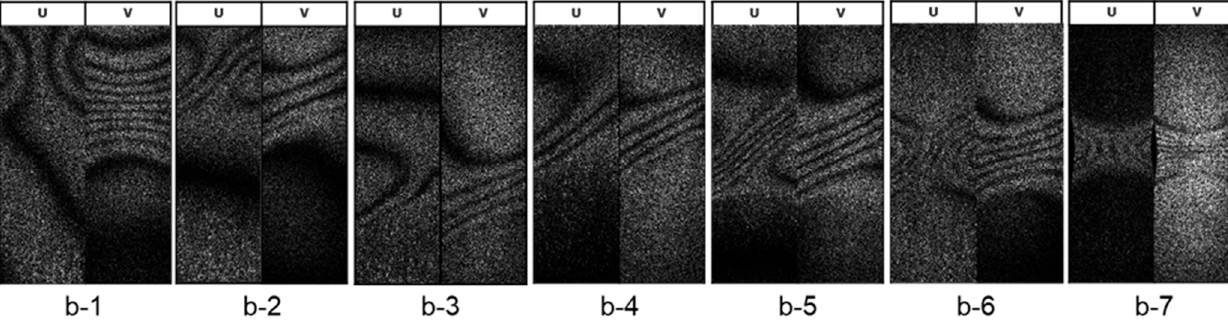
Figure 9. Evolution of fringe patterns observed in tensile test of 7075-annealed alloy. Images (b-1 to b-7) show the patterns observed at the strains marked in Figure 7.